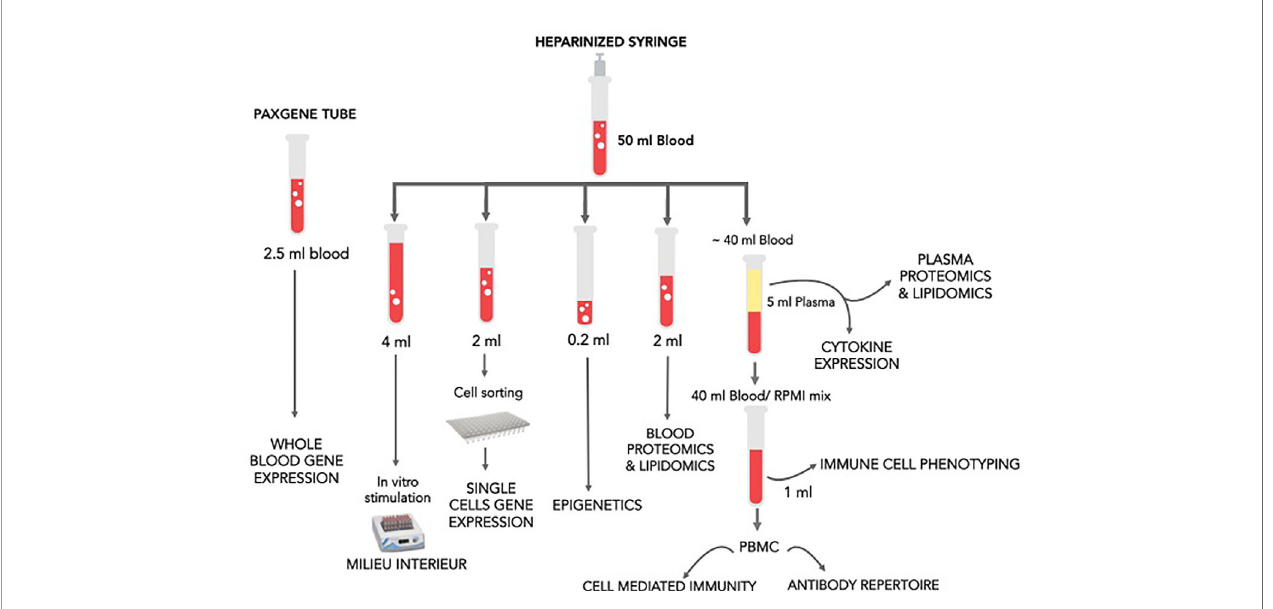
FIGURE 3 | Omic sample processing